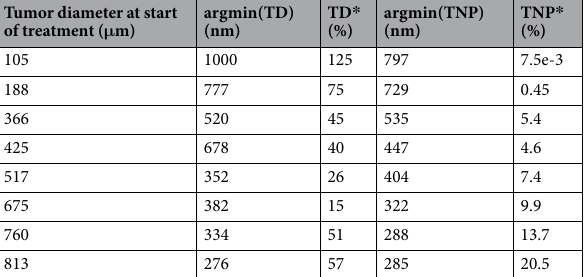
Table 1. Optimal nanoparticle diameters obtained by solving the optimization problems in Eqs. (1) and (2) for the chosen cohort of tumors. Asterisks indicate optimal values. TD: ratio of tumor diameter after treatment to diameter at start of treatment; TNP: percent of injected nanoparticles that accumulate in tumor